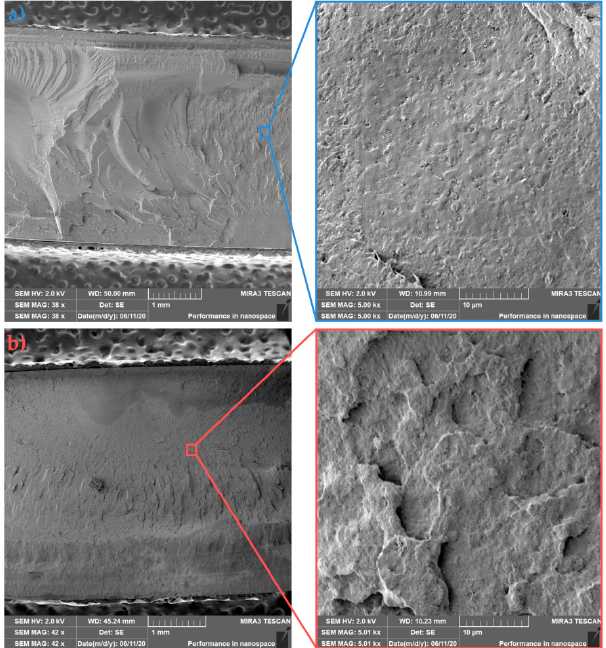
Figure 12. Fracture morphologies of ( a ) cold and ( b ) hot mold PLLA/5PDLA/1HA.